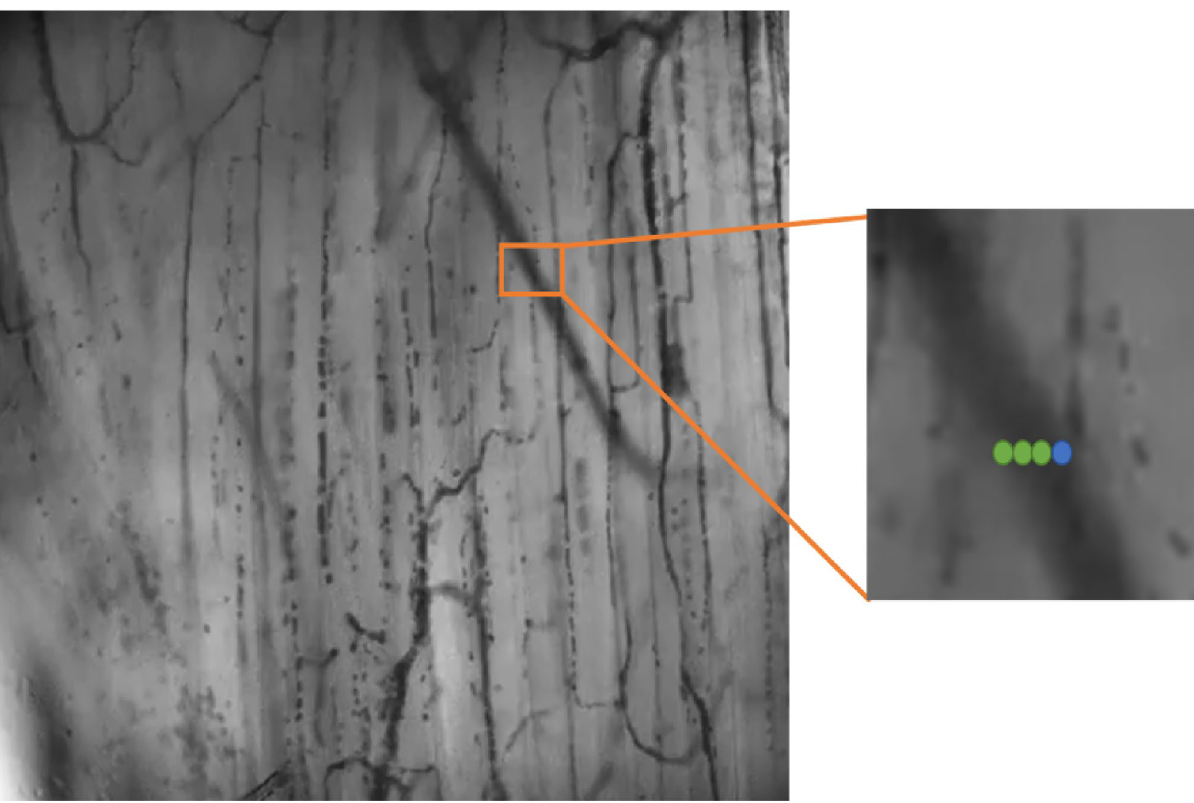
Figure 8. Pixel detection and 3D-CNN evaluation of a cross-section of a vessel segment. It shows a group of 4 pixels across a vessel, of which 75% (3 green pixels) are labeled as flowing, and 25% (1 blue pixel) is labeled as non-flowing. Since the threshold is set at 50%, this vessel is labeled by the algorithm as flowing 45,46